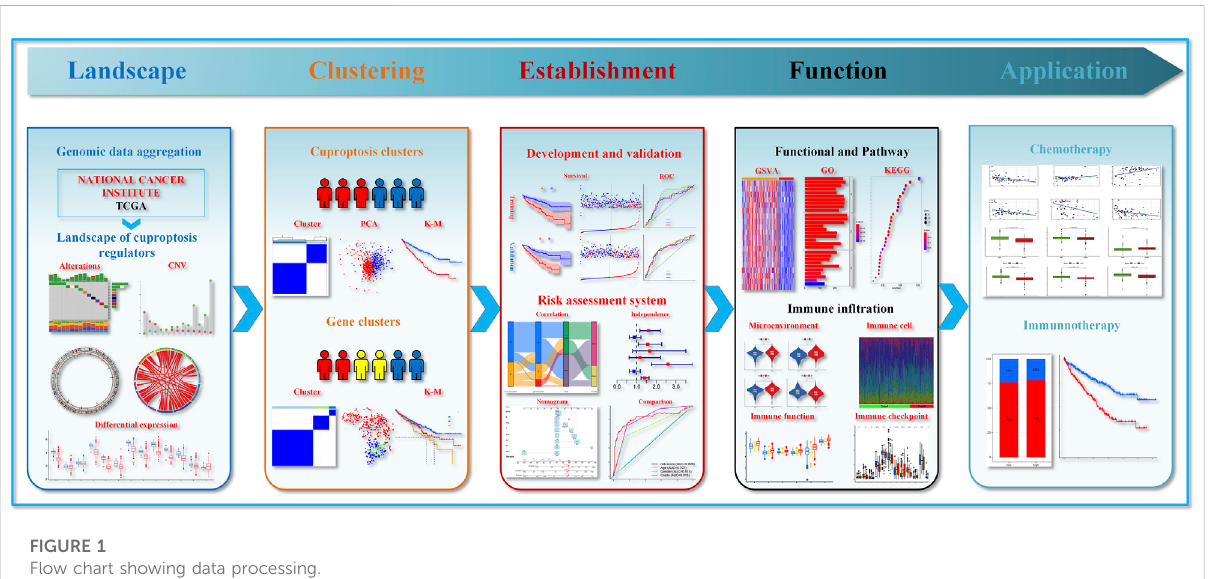
FIGURE 1 Flow chart showing data